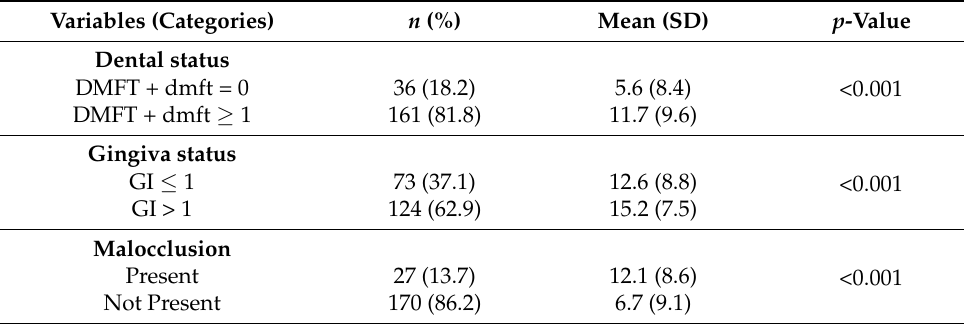
Table 4. Findings for discriminant validity of